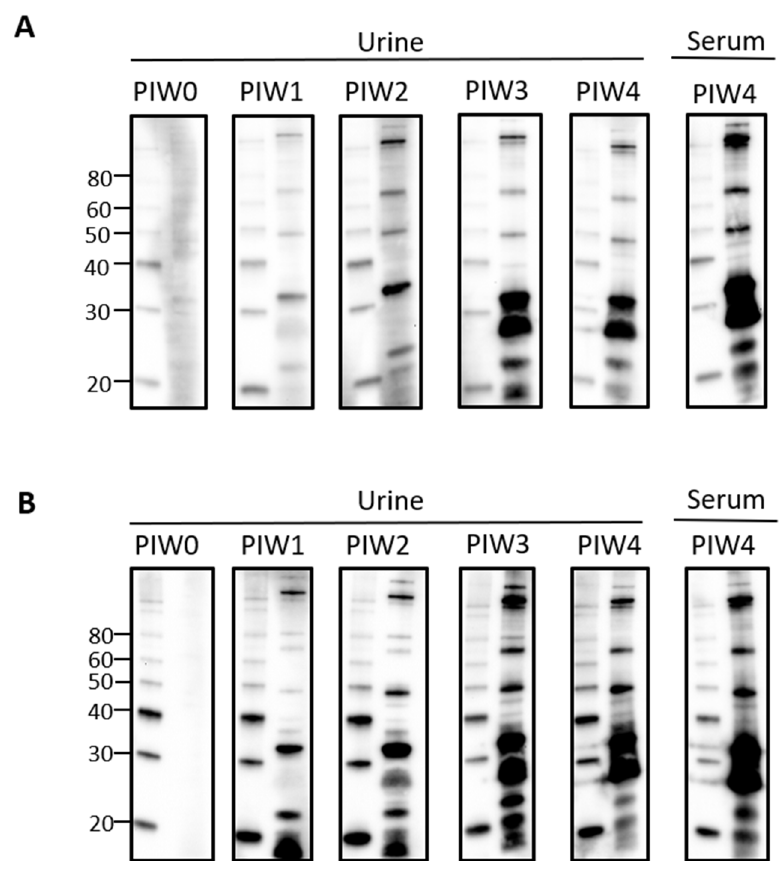
Figure 2. Time course for the detection of urinary IgG specific for leptospires in intraperitoneally infected rats. Representative immunoblots of leptospires with urine collected from ( A ) rat 18 or ( B ) rat 21 at PIW 0, 1, 2, 3, and 4, or serum collected at PIW4. Molecular mass markers (M) are indicated in kDa and are shown in the left lane of each immunoblot compared to the antigen of leptospires in the right lane.